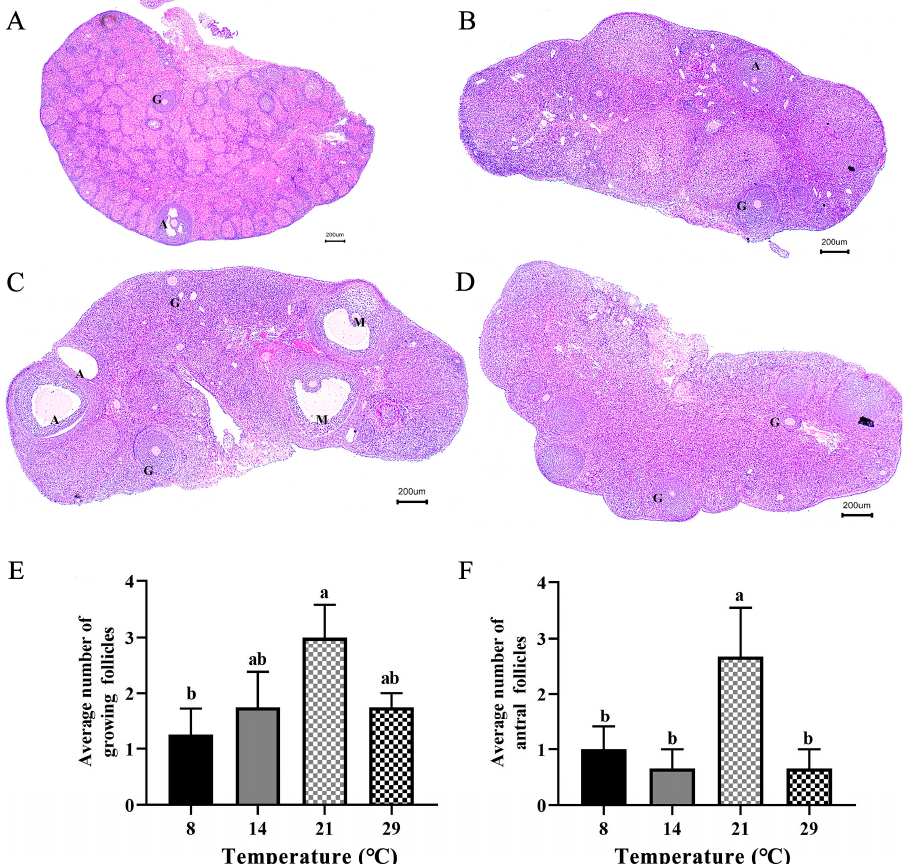
Figure 1. Differences in the number of follicles by HE staining of ovarian section in Phodopus sungorus at 8 °C, 14 °C, 21 °C, and 29 °C. ( A ) Ovarian section of individuals from 8 °C. ( B ) Ovarian section of individuals from 14 °C. ( C ) Ovarian section of individuals from 21 °C. ( D ) Ovarian section of individuals from 29 °C. ( E ) Differences in the average number of growing follicles on per cross section under different temperatures. ( F ) Differences in the average number of antral follicles on per cross section under different temperatures. G, growing follicle; A, antral follicle; M, mature follicle. Values are means ± SEM. Bar = 200 µm; n = 4. Different letters above the columns indicate significant differences ( p < 0.05).